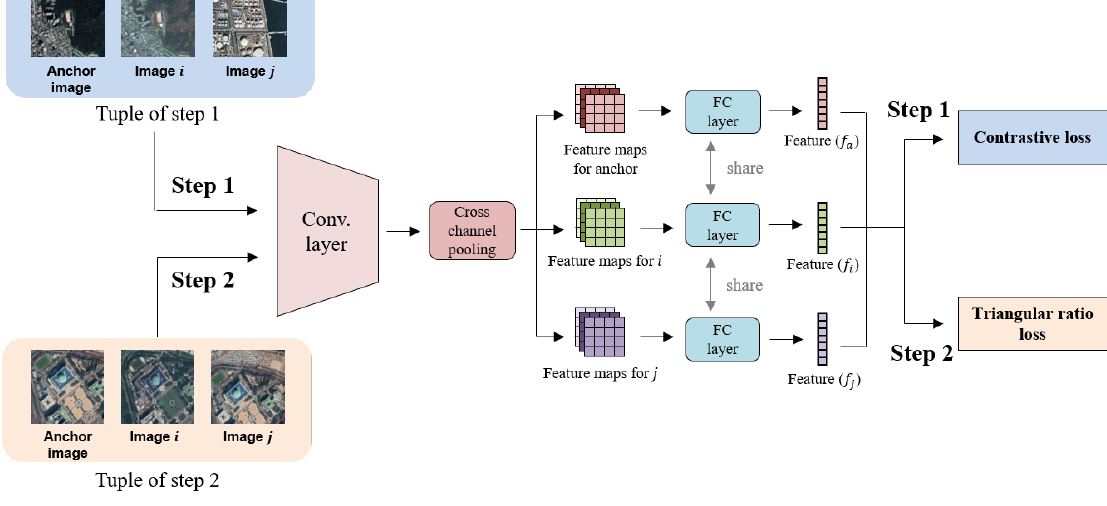
Figure 5. Overall architecture of the proposed training step. There are two streams: (i) Training with the contrastive loss function using Step 1 tuples, which contain two same images and one different image. (ii) Retraining with the triangular loss function using Step 2 tuples, which consist of three same region